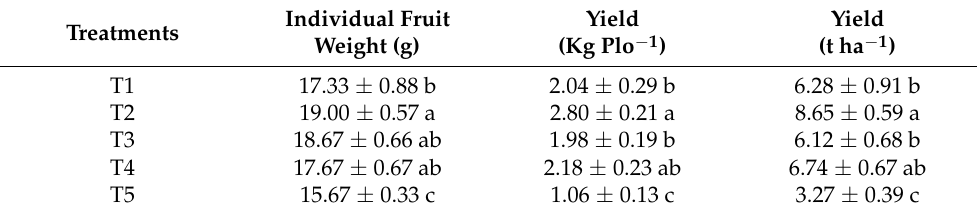
Table 4. Effect of different insecticides on OSFB in okra fruit